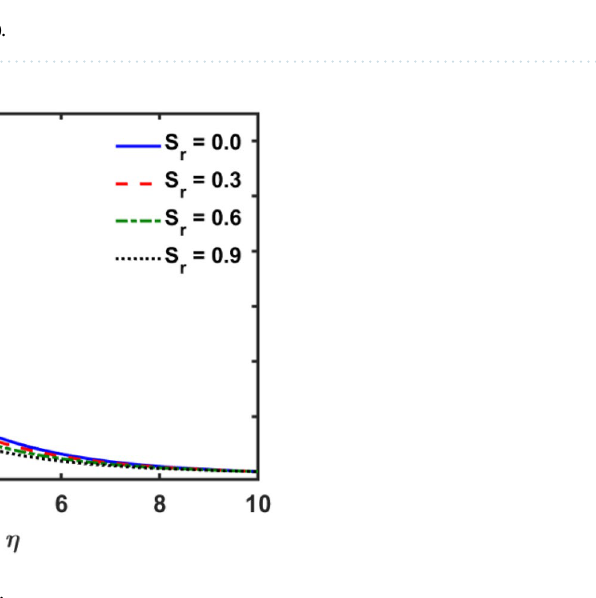
Figure 17. Variation of S r on φ(η)